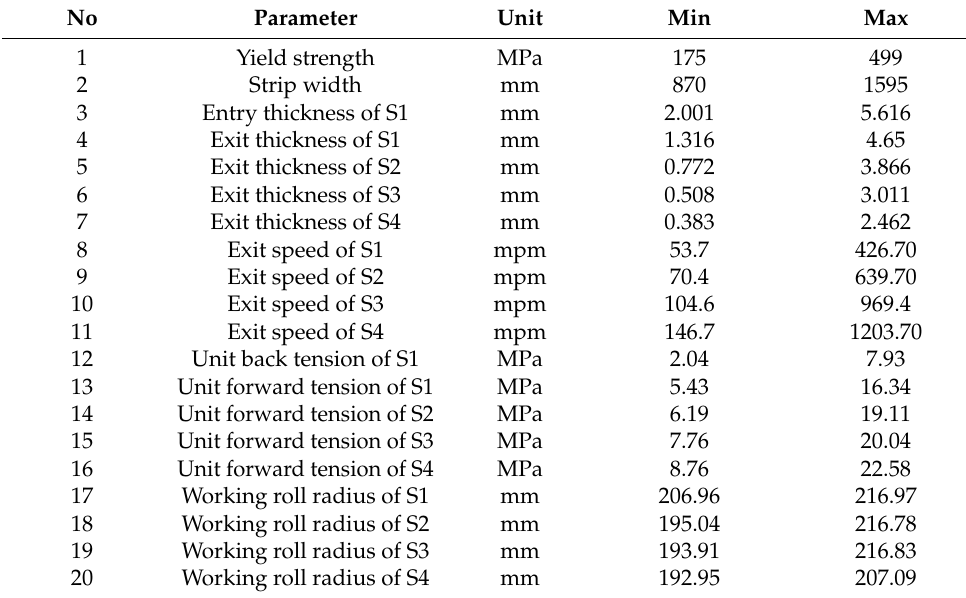
Table 1. BP neural network input parameters.